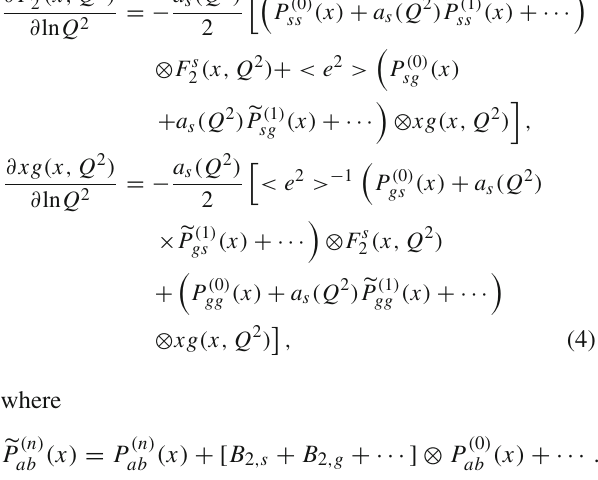
The fitted parameters are tabulated in Table 1. In terms of the measured structure function F 2 ( x , Q 2 ) (i.e., Eq. (7)), the gluon distribution function is determined due to the Laplace transform method in Ref. [11]. In the case of four massless quarks, the gluon distribution function is obtained with a quadratic expression in both ln Q 2 and ln ( 1 / x )